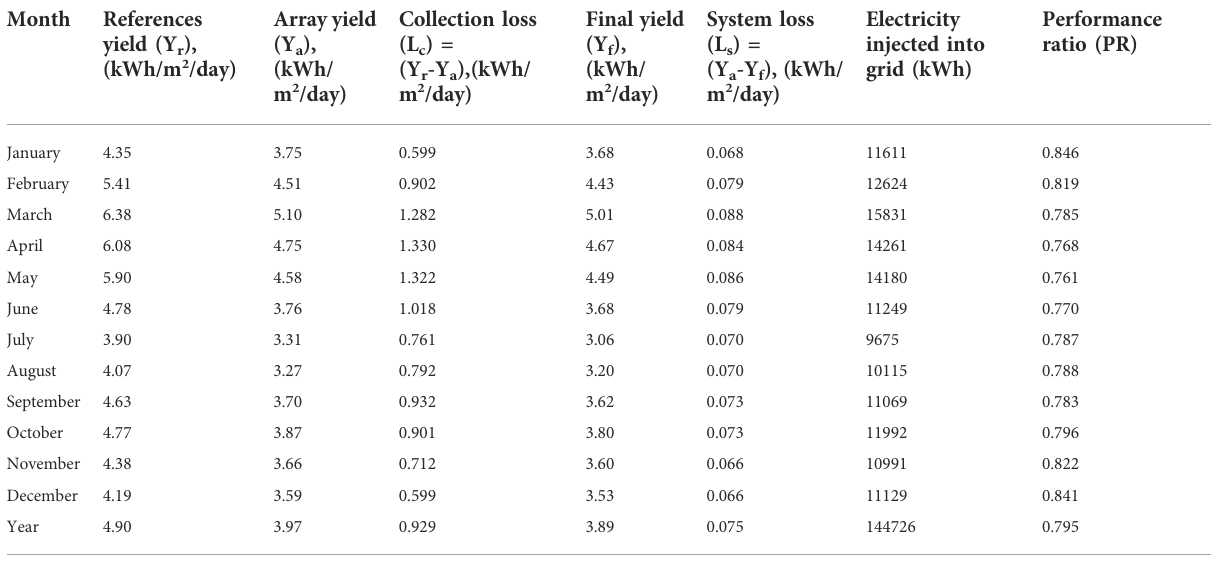
TABLE 6 Various yields of the proposed PV plant and electricity injected into the grid.